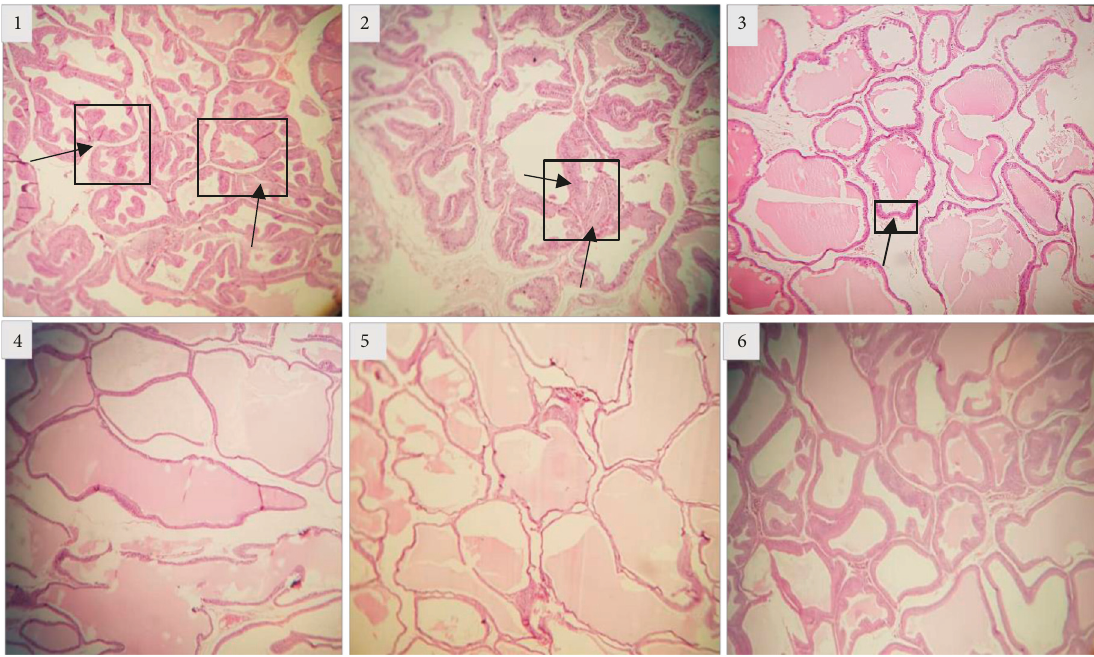
Figure 5: Microscopic images (40x) of the prostate tissue (H&E). The arrows and squares represent morphology changes such as stromal proliferation, abnormal acinar fold, and hypertrophy, ((1) and (2)) treatment with muscle injection testosterone, (3) treatment with extract at dose of 300mg/kg, (4) treatment with extract at dose of 600mg/kg, (5) treated with finasteride as standard medicine, and (6) treated with corn